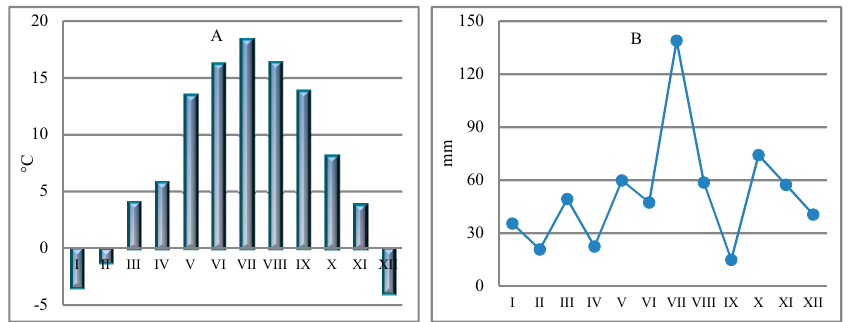
Figure 2. Annual temperature ( A ) and average monthly precipitation ( B ) for Bydgoszcz. The designated final landfill area is 5.0 ha. The foreseeable maximum annual amount of waste for storage is 180,000 Mg. The landfill has a capacity of 5,250,000 m 3 and receives a maximum of 500 Mg of waste per